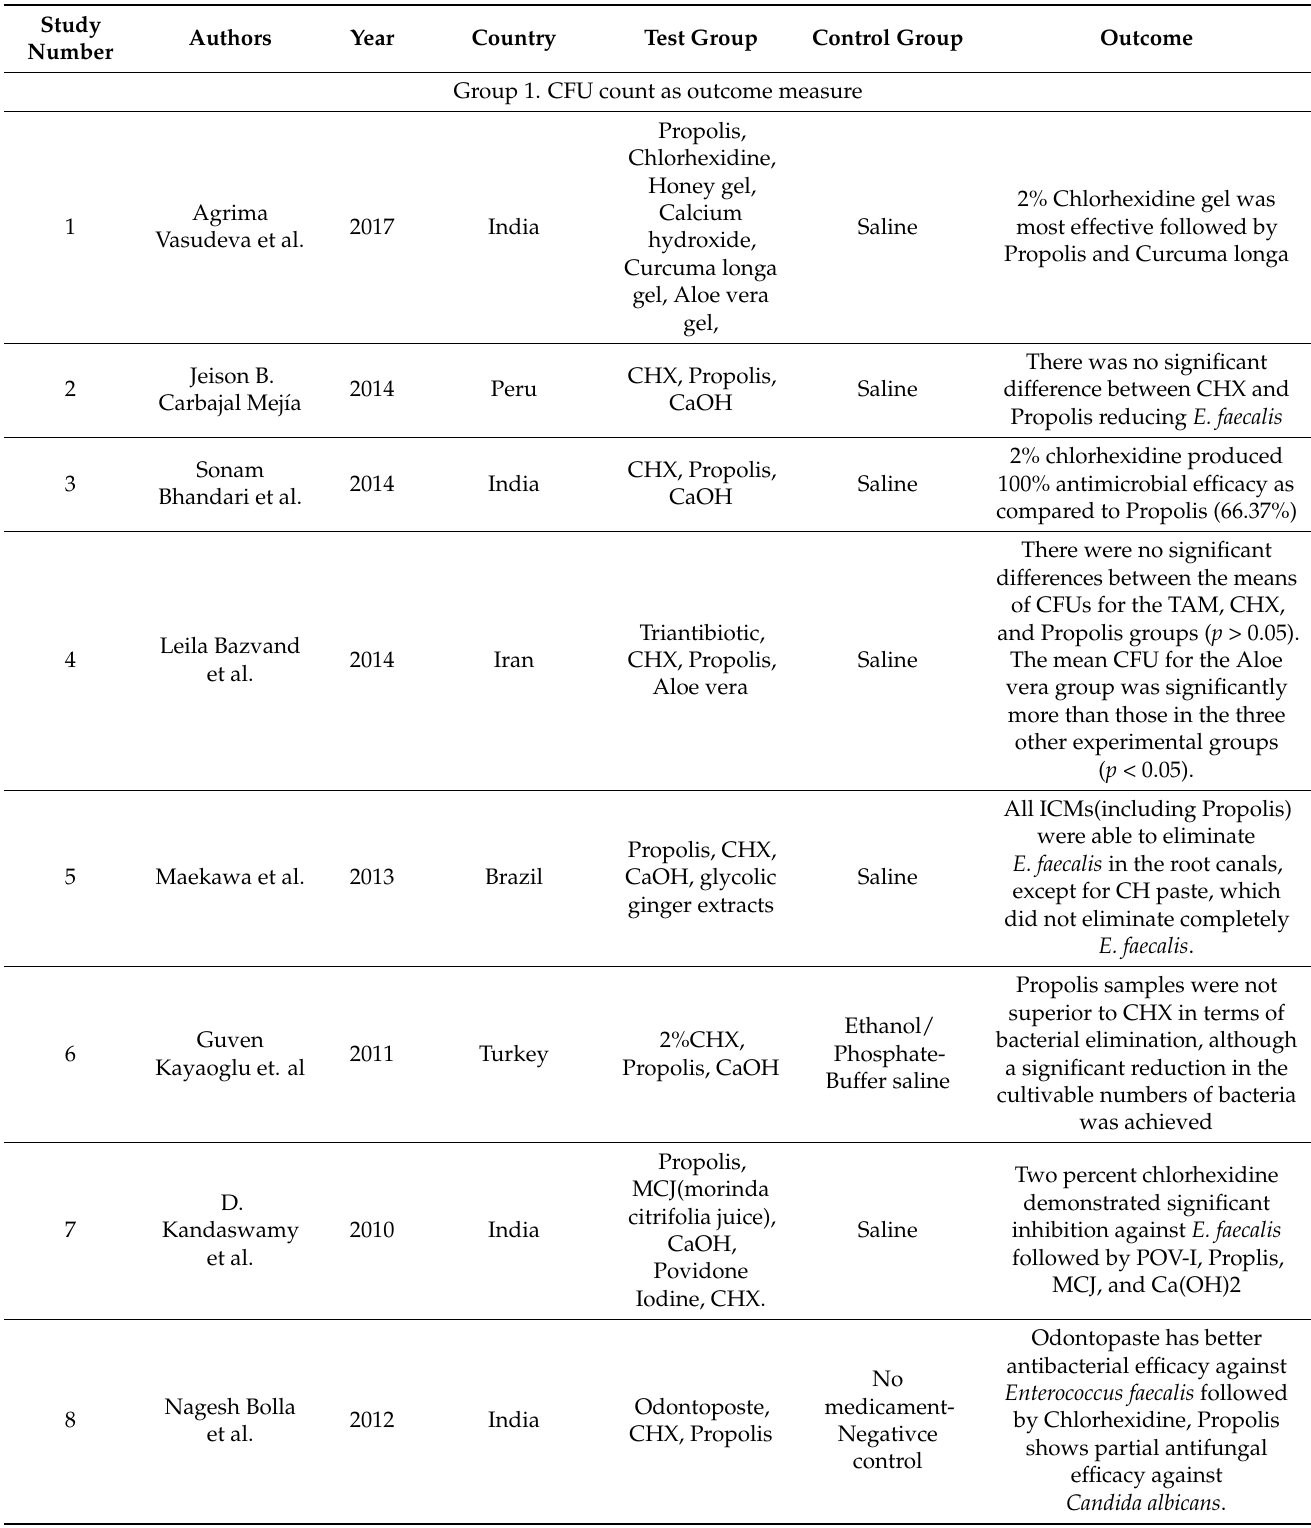
Table 1. General characteristics of included